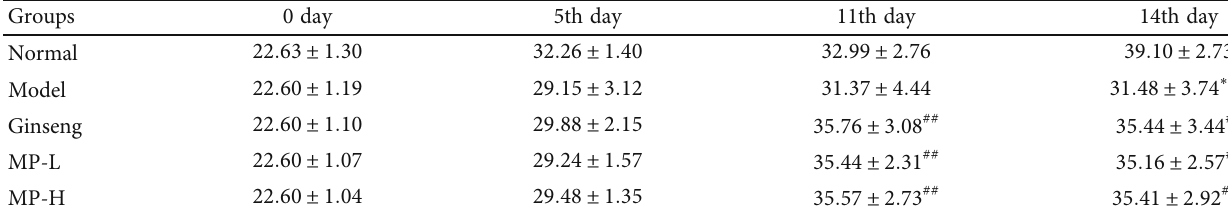
Table 2: Body weights of mice (g; x ± s ; n = 12